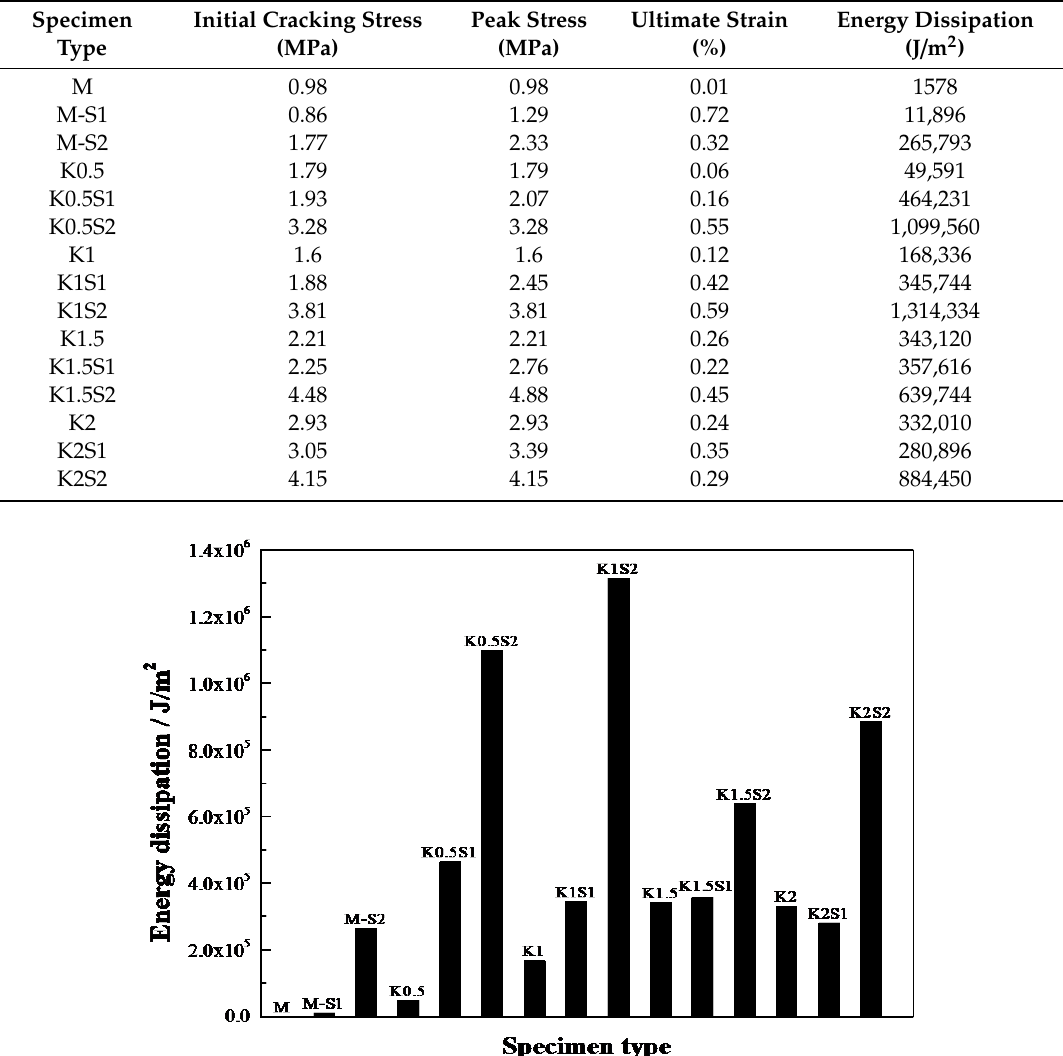
Figure 8. Comparison of energy dissipation of different types of steel grid-KEVLAR fiber reinforced ECC specimens.